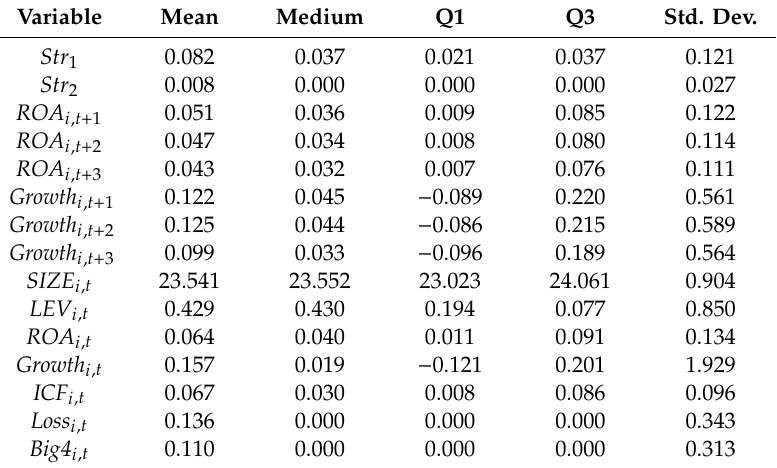
Table 3. Descriptive statistics a